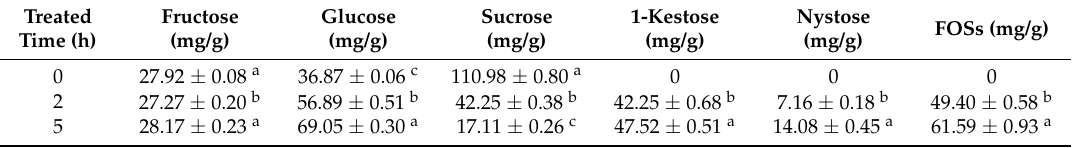
Table 3. Sugar contents of longan juice before and after enzymatic treatment *.